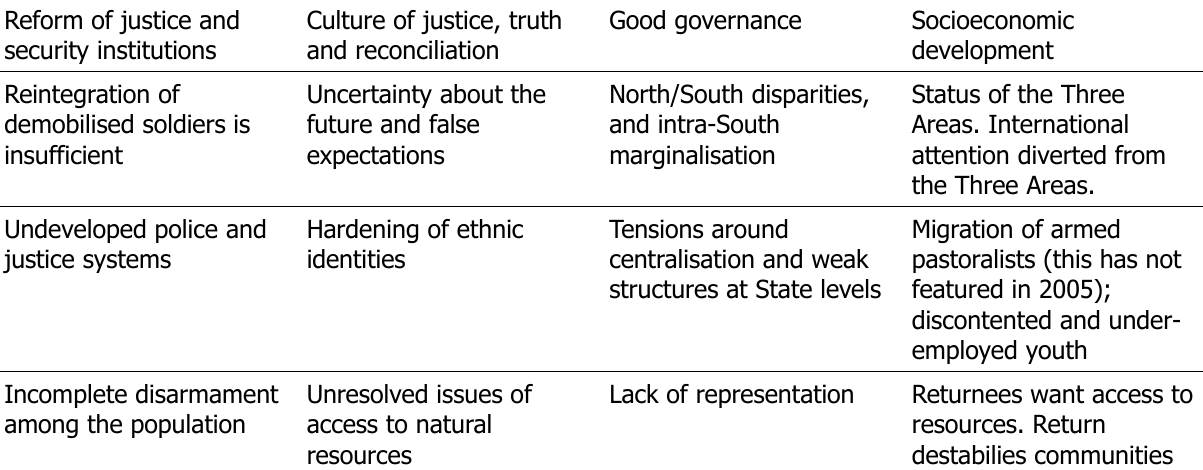
Table 1. Key areas of conflict addressed by international